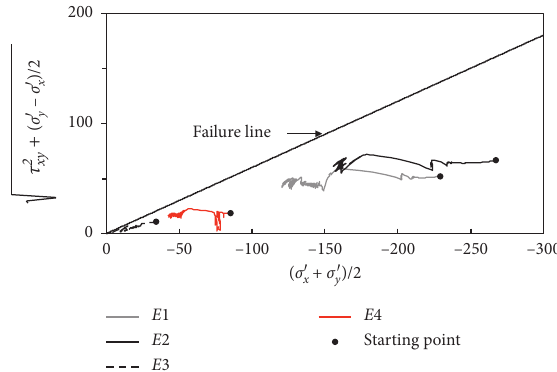
Figure 17: Effective stress path of soil elements in seabed during wave loading.